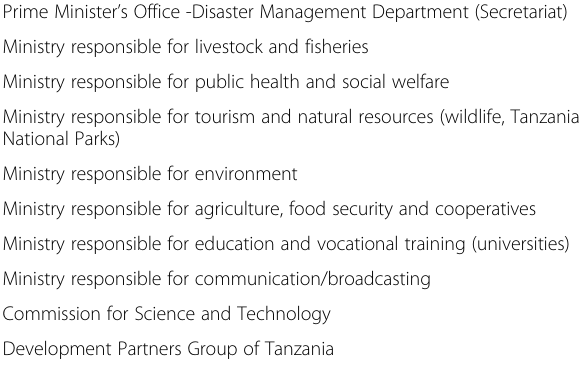
Table 4 Core ministries, institutions and partners